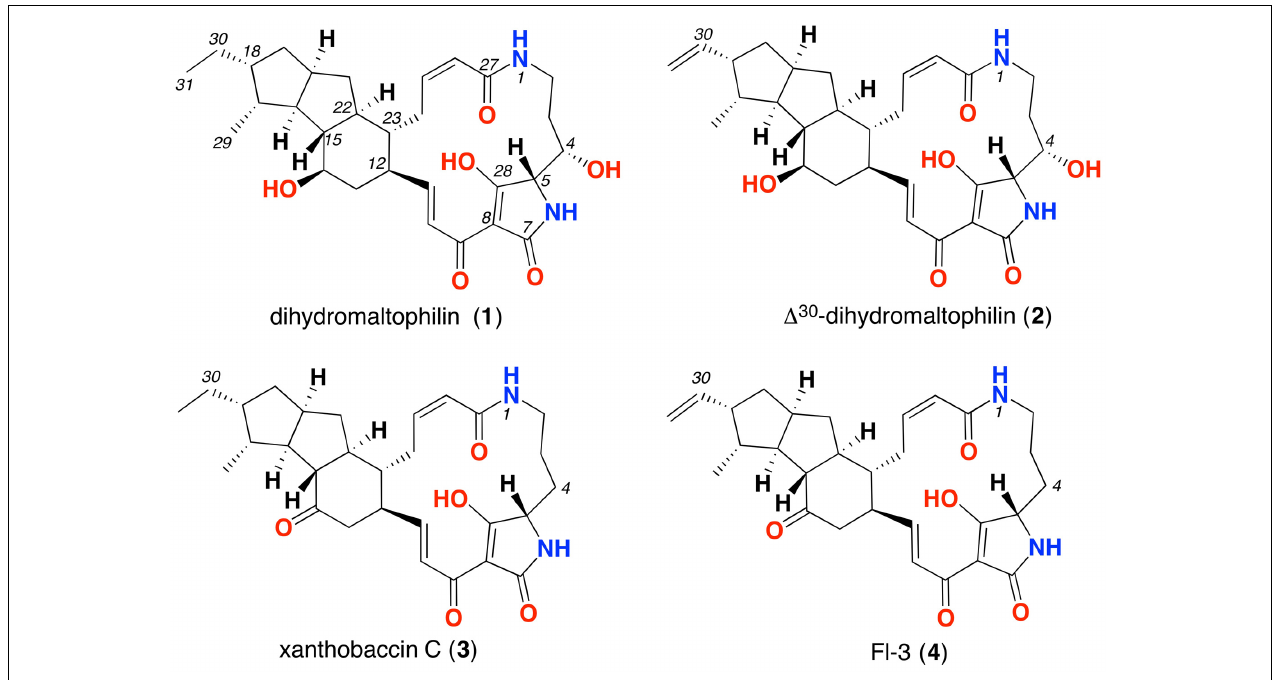
FIGURE 3 | Structure of PTMs produced by cone snail-associated Streptomyces